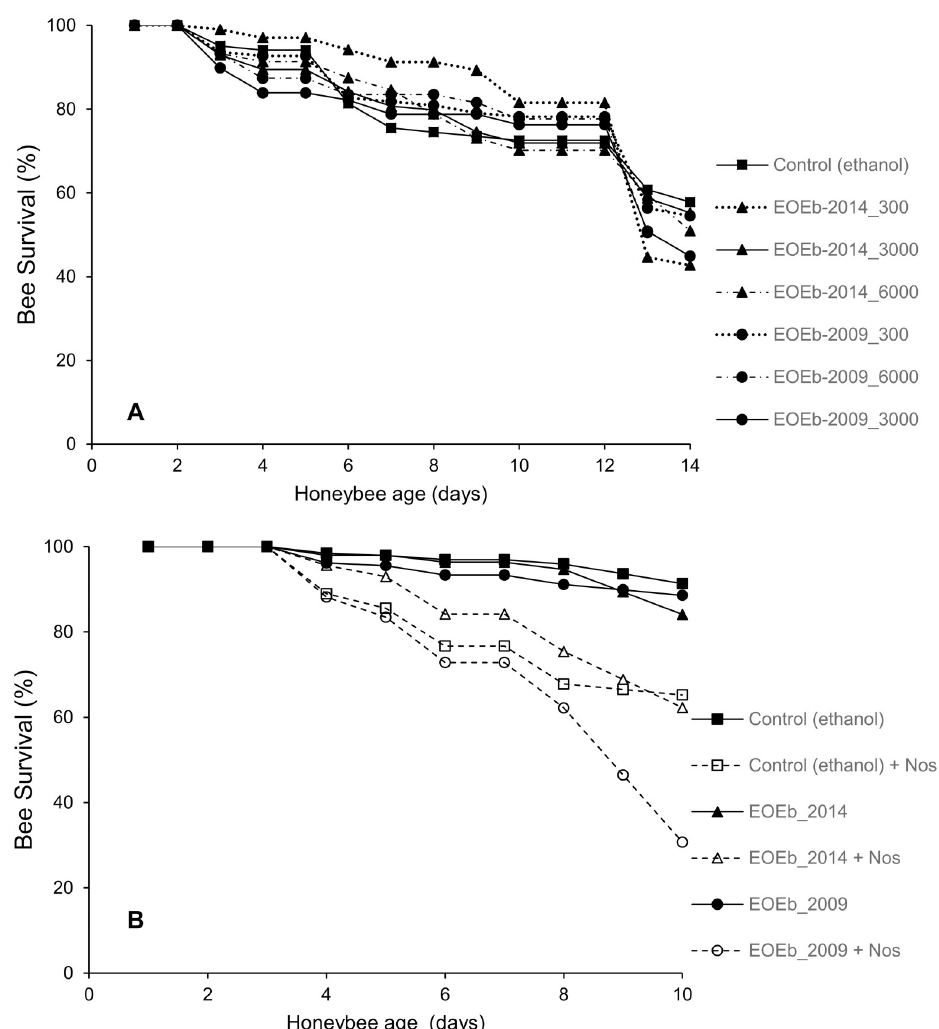
Fig 2. Survival of honeybees fed on diets enriched with E . buniifolium EO. EOs produced at different harvest times (2009 and 2014) were tested: on healthy honeybees at different doses ( A ) and on healthy (solid symbols) and Nosema - infected (open symbols) honeybees at 3000 ppm ( B ). For healthy bees ( A ), no differences were found among honeybees fed with the EOEb at different doses (ANOVA, GLM, p = 0.65 for treatment and p = 0.13 for the interaction treatment � time), and survival decreased with time (p < 0.05). For Nosema -infected honeybees ( B ), significant differences (ANOVA; GLM) were found related to health status (P < 0.001) and time (P < 0.001) but not related to diet (P = 0.6). Error bars are not shown for clearness of the